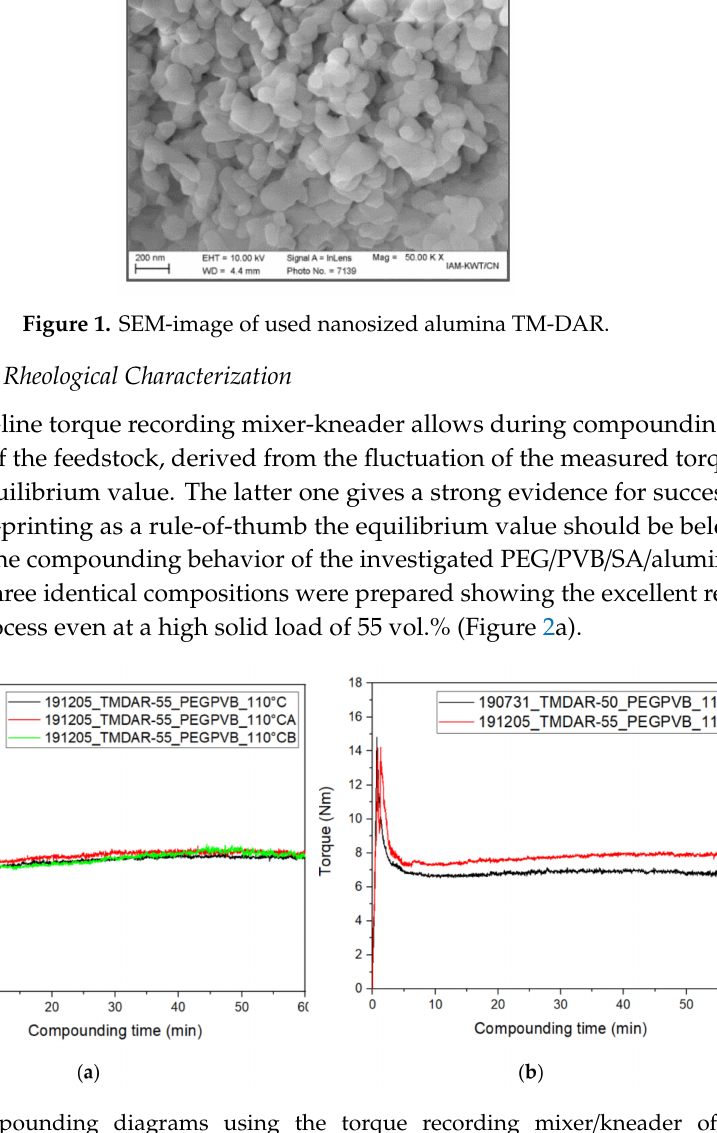
Figure 2. Compounding diagrams using the torque recording mixer / kneader of alumina in polyethyleneglycol (PEG) / polyvinylbutyral (PVB) (T = 110 ◦ C, 30 rpm); ( a ) Record of three di ff erent measurements with identical feedstocks (55 vol.%); ( b ) Torque comparison at di ff erent solid